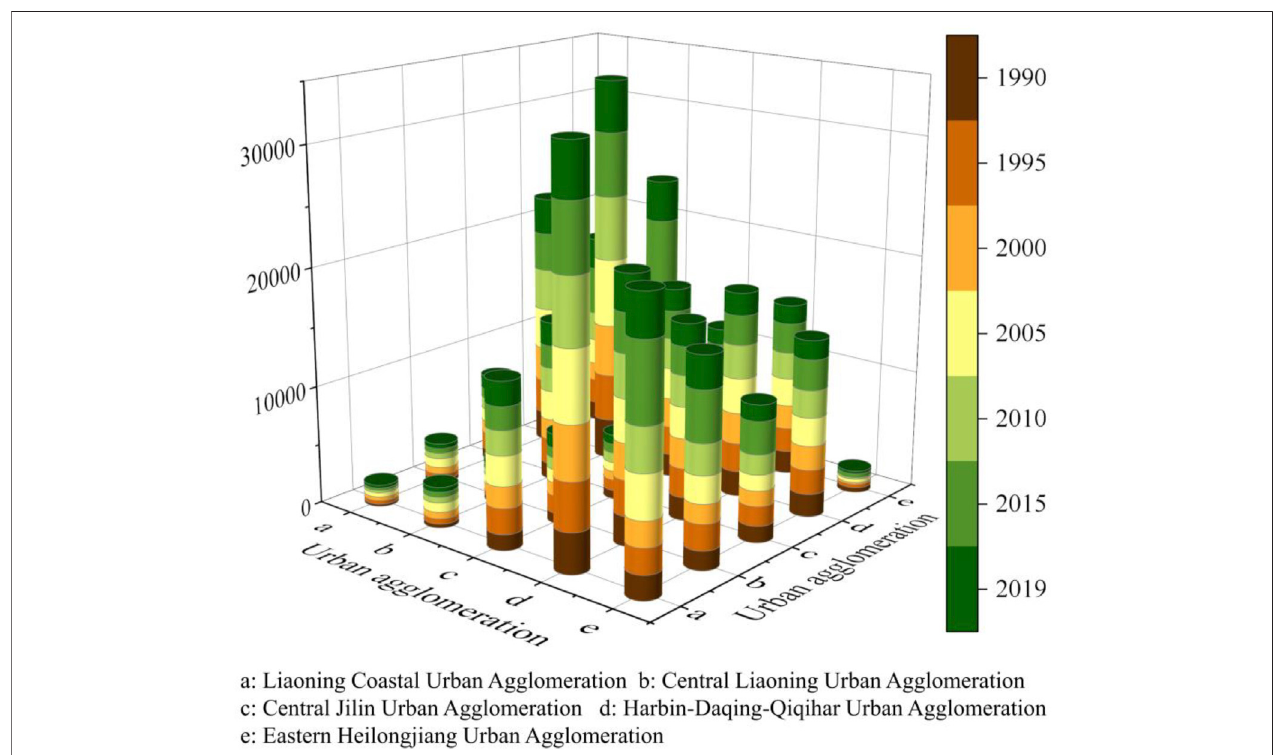
FIGURE 7 | Difference coef fi cient matrix between urban